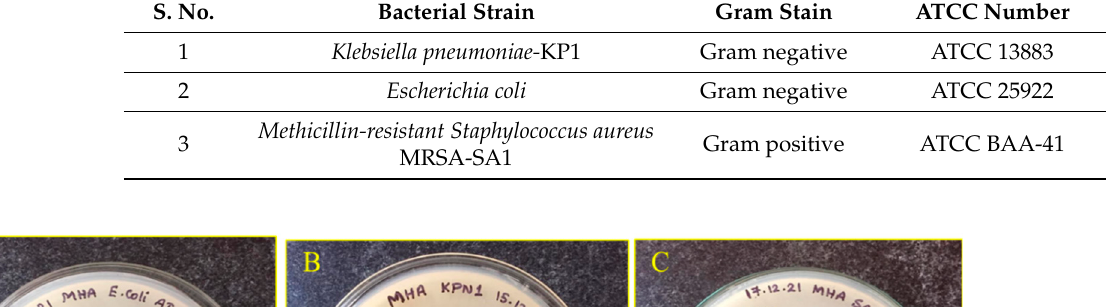
Table 10. Scientific name/ strain for the organisms used in the study. S. No.